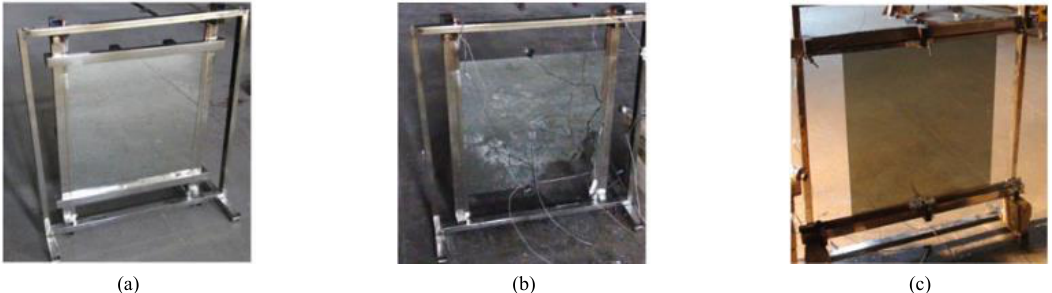
Fig. 8 The test setup for (a) case 1: exposed frame, (b) case 2: horizontal-hidden frame, (c) case 3: vertical-hidden frame (Wang